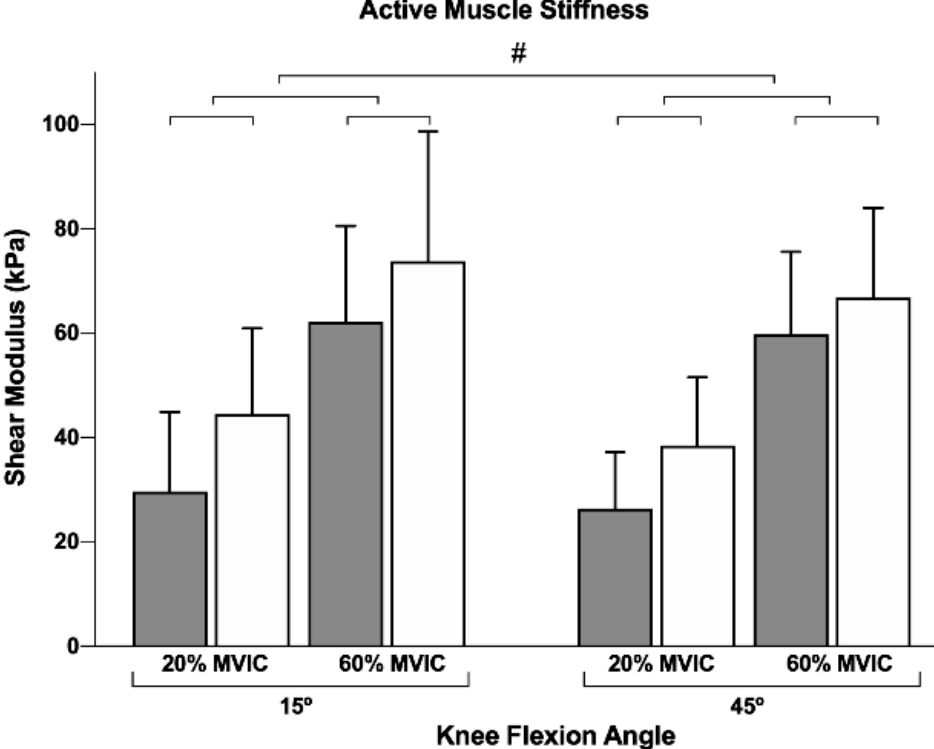
Figure 1. Biceps femoris long head active stiffness at proximal (grey bars) and distal (white bars) regions during knee flexion contractions at 15° and 45° of knee flexion and 20% and 60% of MVIC 15° . MVIC 15 —maximum voluntary isometric contraction at 15° of knee flexion. All data are presented as mean ± standard deviation. # indicates a statistically significant difference ( p < 0.05).